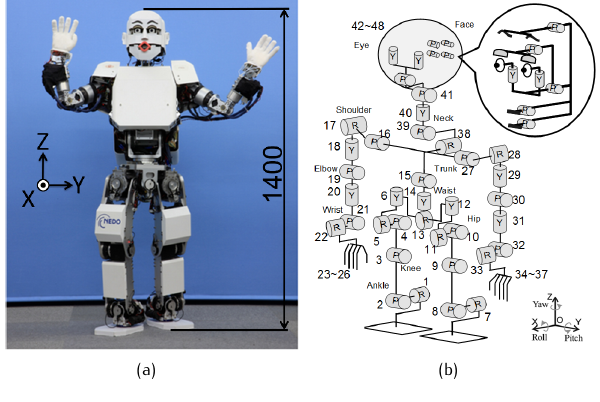
Figure 1. Emotion expressive humanoid robot KOBIAN: a) Overview (b) DoF